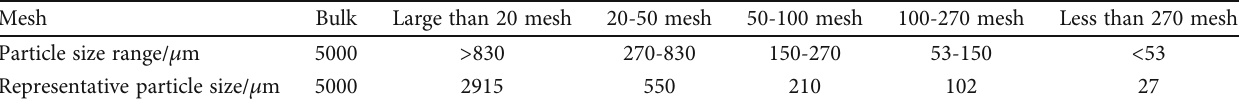
Table 1: Six particle sizes of shale sample